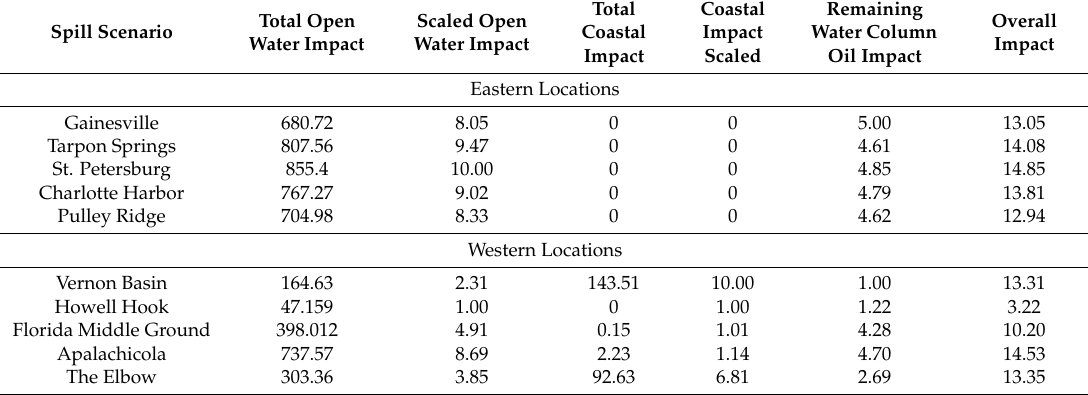
Table 3. Total scaled impacts for each impact area of the spill scenarios. Overall impacts are denoted in the last column and are the sum total of coastal impacts, water column impacts, and remaining oil